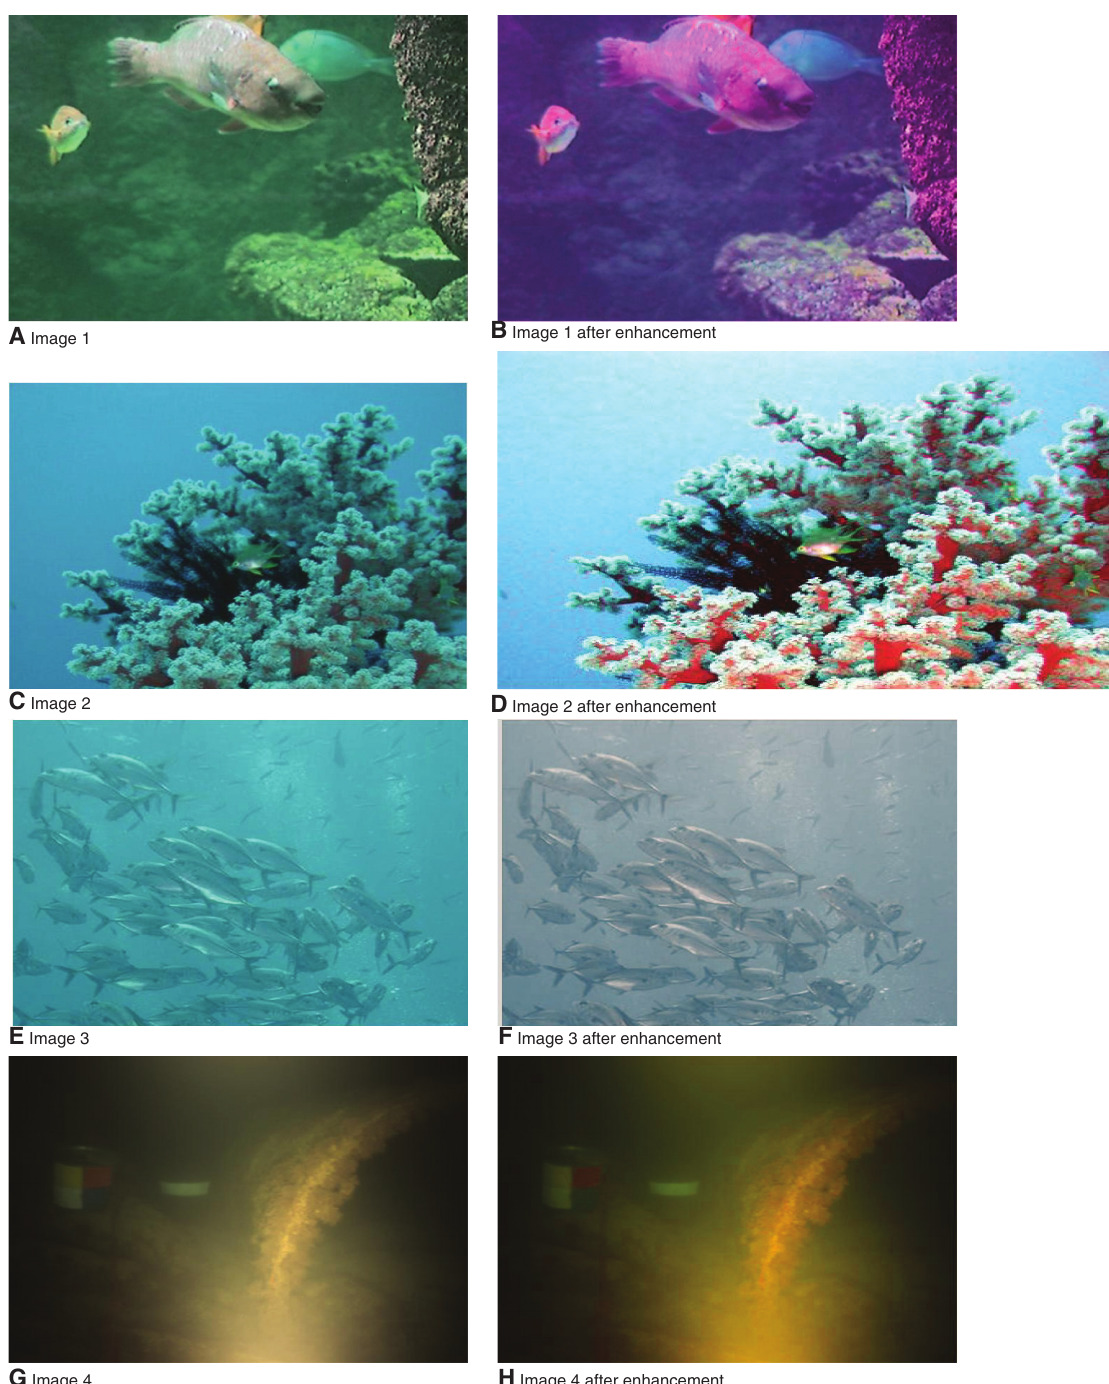
Figure 3. The Original and Enhanced Underwater Image after Applying the PSO